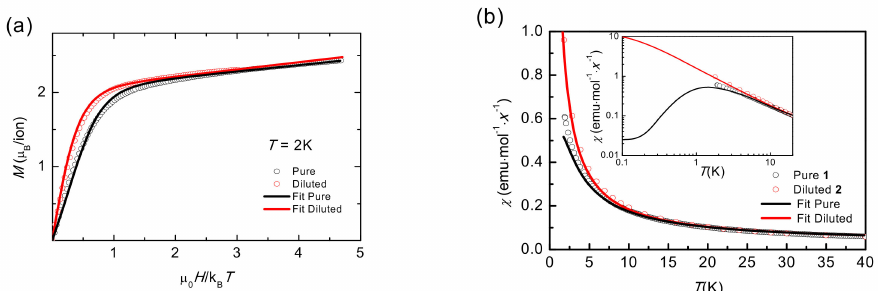
Figure 5. ( a ) Field dependence of the magnetization, M ( H ), measured at T = 2 K for 1 and 2 . ( b ) Low temperature detail of magnetic susceptibility χ ( T ) data at 1. kOe for 1 ( x = 1) and 2 ( x = 0.2). The lines correspond to fits with Equation (3) using the g * components deduced from the EPR measurements, the intra-rung anisotropic exchange constants J * x /k B = − 0.5 K, J * y /k B = − 2.3 K, and J * z /k B = − 0.5 K, and integrating over the randomly oriented grains. A Van Vleck contribution is added to the magnetization simulated curves. For the diluted compound the dimer exchange interaction is not considered in the